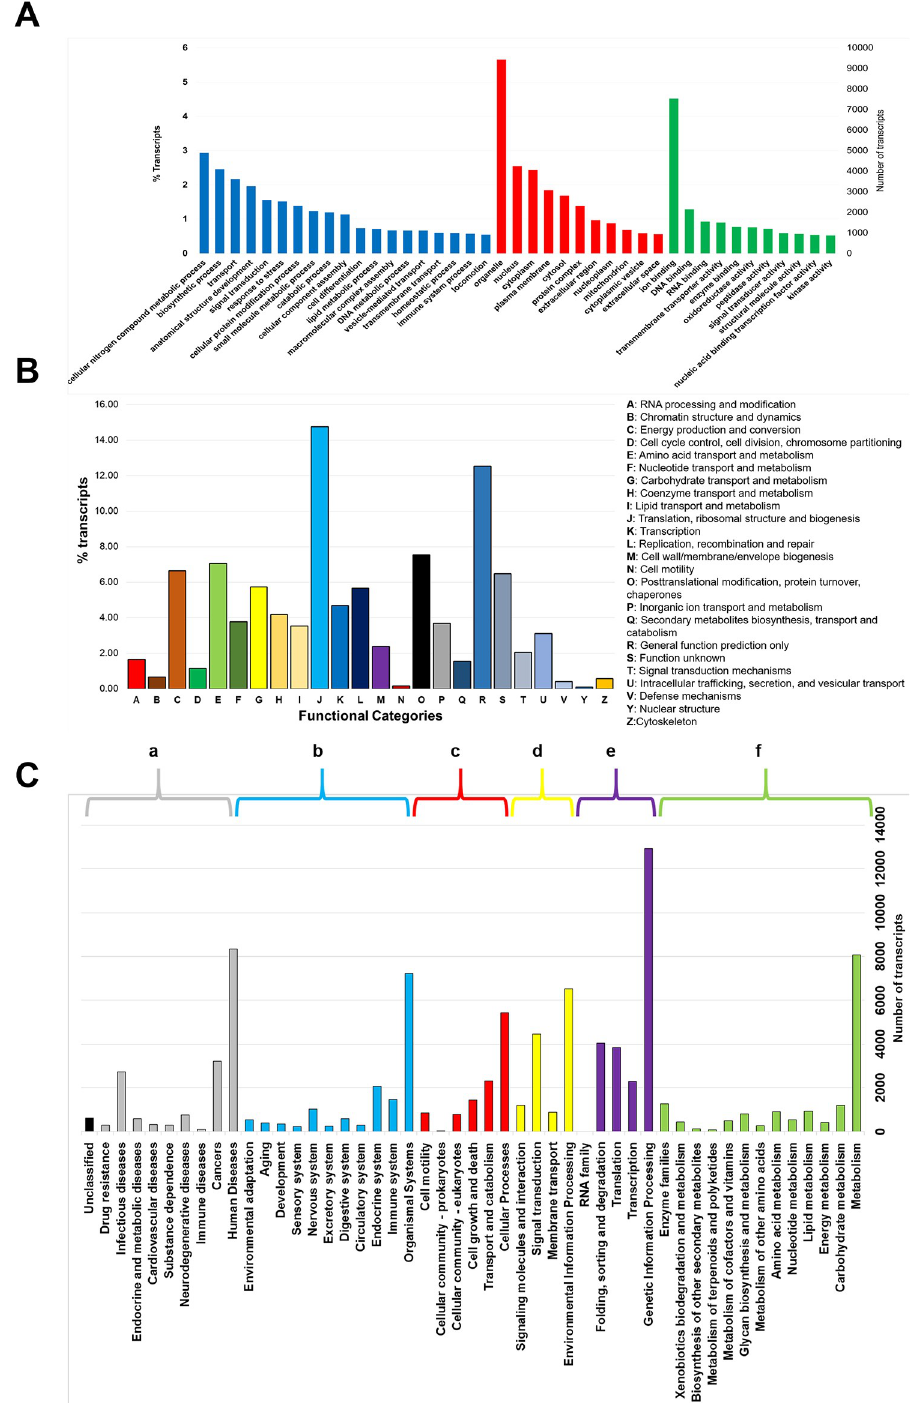
Fig 4. Annotation of Litopenaeus vannamei transcripts. Annotated transcripts were classified separately using three database resources: (A) Gene ontology (GO), transcripts were grouped in three different ontologies: biological process (BP) in blue, cellular component (CC) in red, and molecular function (MF) in green. The X- axis shows each GO ontology and all the biological categories that lie in each ontology. The Y- axis in the left hand side (LHS) shows the percentage of transcripts (%) for each individual category and the Y- axis in the right hand side (RHS) the number of transcripts in each category (B) The second functional classification was using the orthologous cluster group (COG). The X- axis represents the protein categories predicted which are listed in the RHS. (C) In the third classification,